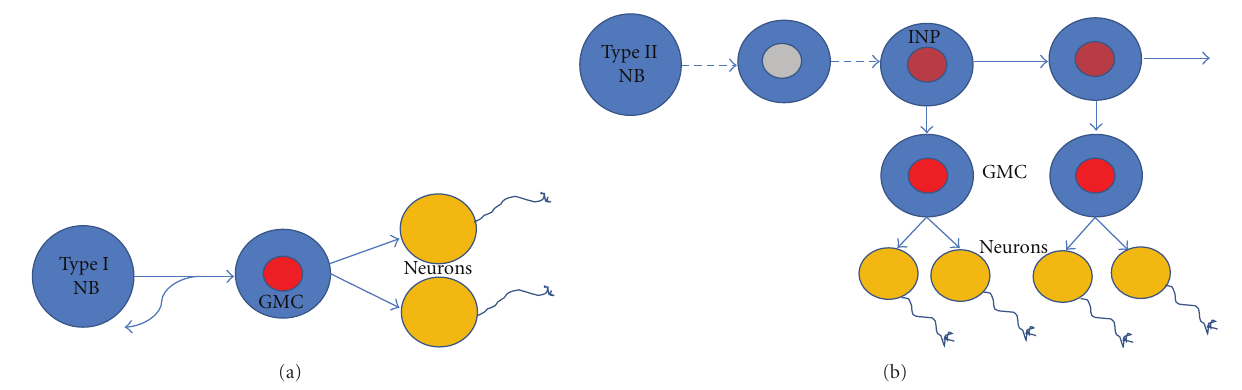
Figure 2: Neural stem cells/neuroblast (NB) undergo two types of self-renewing cell divisions: symmetric (proliferating) and/or asymmetric (di ff erentiating). (a) Type I NB self-renew, and also generates a ganglion mother cell (GMC) which divides only once to generate two postmitotic daughter cells that di ff erentiate into neurons or glial cells [2, 16–18]. (b) Type II NB initiates expression of the proneural gene asense and becomes an intermediate neural precursor (INP), which undergoes self-renewing asymmetric divisions, with each division resulting in one INP and one GMC [22–26]. Type II NB generates much larger lineages compared to type I NB.